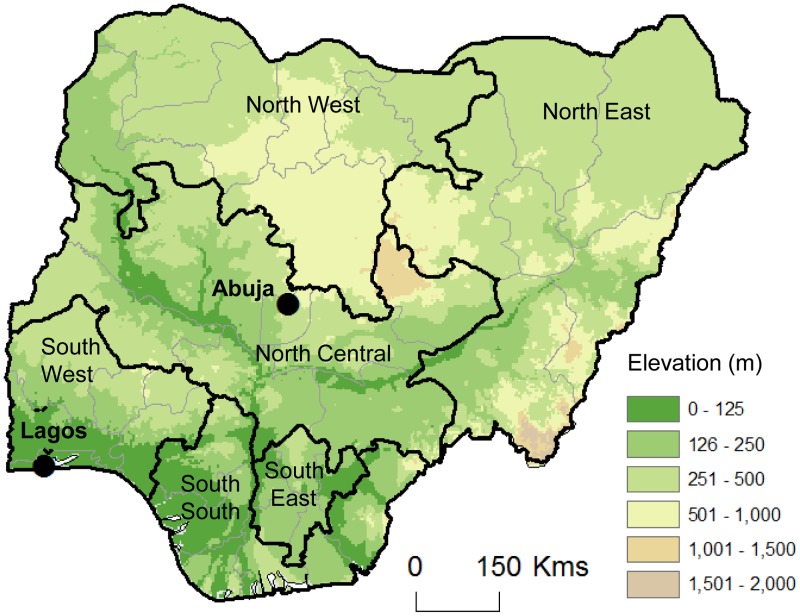
Map of Nigeria and its geopolitical zones.North Central - Benue, FCT, Kogi, Kwara, Nasarawa, Niger, Plateau. North East - Adamawa, Bauchi, Borno, Gombe, Taraba, Yobe. North West - Kaduna, Katsina, Kano, Kebbi, Sokoto, Jigawa,, Zamfara. South East - Abia, Anambra, Ebonyi, Enugu, Imo. South - Akwa-Ibom, Bayelsa, Cross-River, Delta, Edo, Rivers. South West - Ekiti, Lagos, Osun, Ondo, Ogun, Oyo. Note: Elevation data based on ETOPO2 global 2-minute gridded resolution from National Oceanic and Atmospheric Administration (NOAA) available from ESRI Redland, CA.